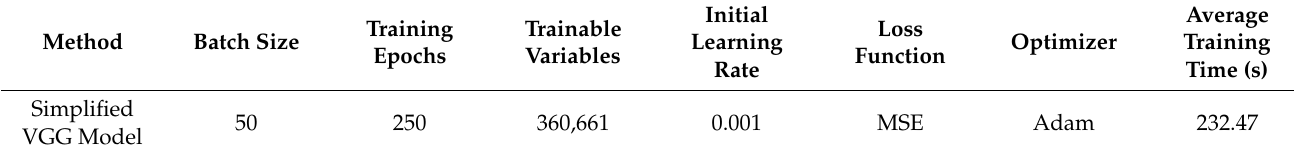
Table 2. Parameters assigned in the simplified VGG